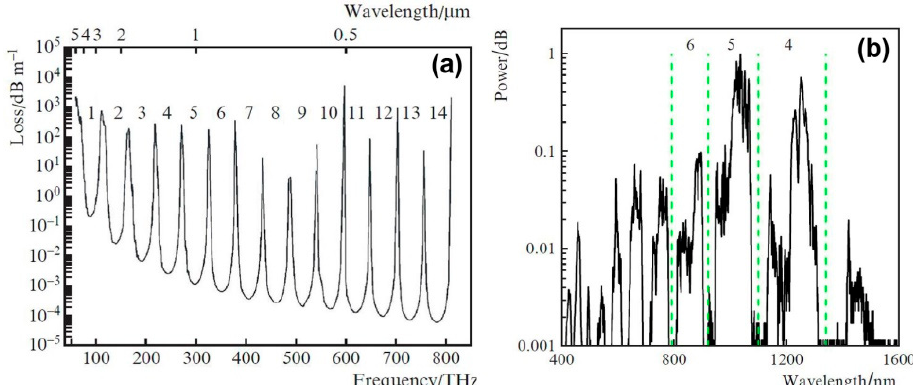
Figure 18. ( a ) Calculated losses for the fundamental mode in the spectral range corresponding to 14 transmission bands; and, ( b ) Laser emission spectrum measured at the output of the 3-m-long fiber at the input pulse energy of 110 μ J [80].